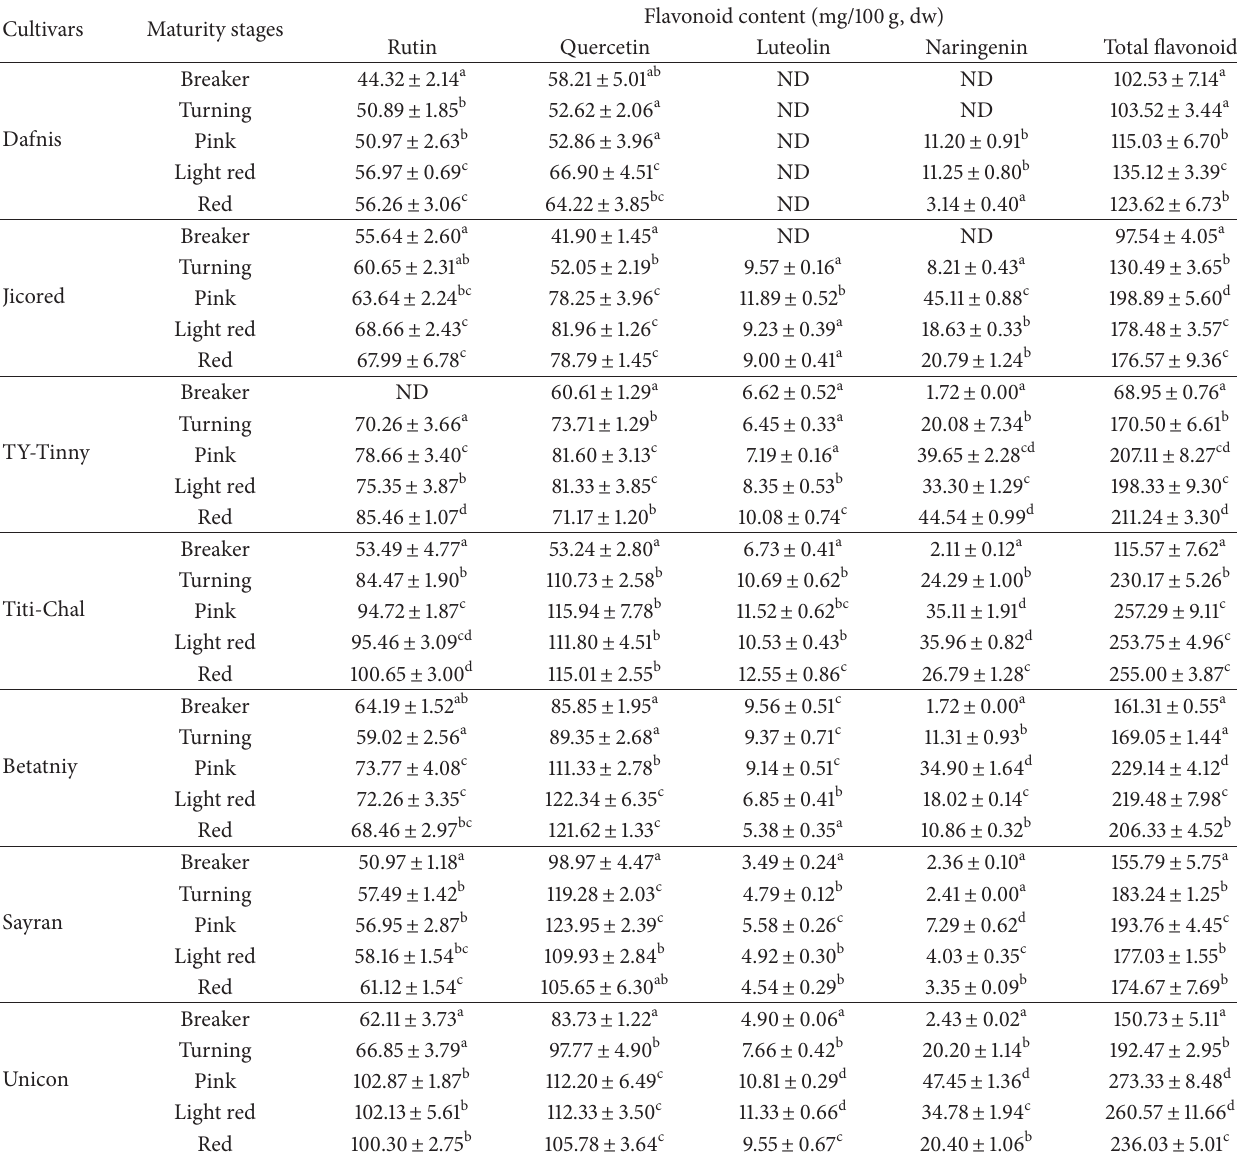
Table 3: Flavonoids content in tomato fruits at different ripening